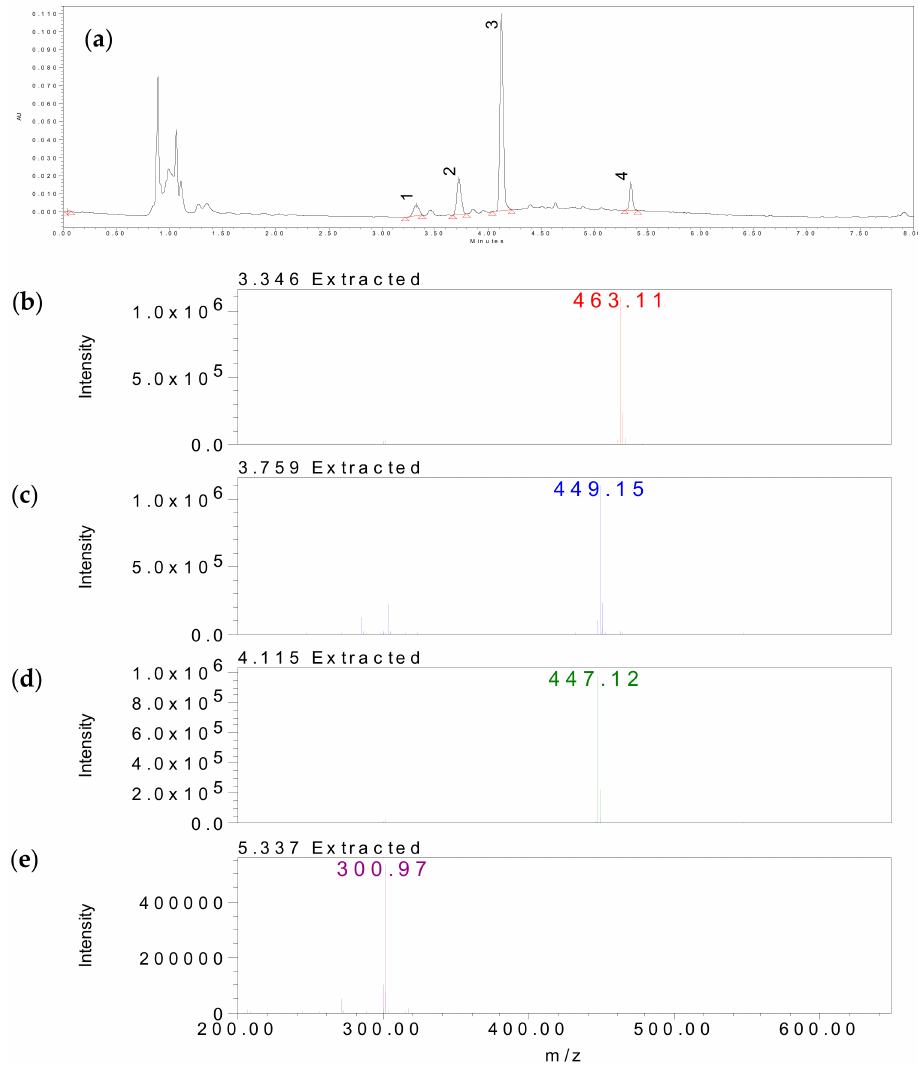
Figure 3. UPLC-DAD chromatograms obtained at 270 nm from Hypericum formosanum extract (HFE); ( a ) 1 = Hyperoside, 2 = Astilbin, 3 = Quercitrin, 4 = Quercetin; ( b ) MS of Hyperoside; ( c ) MS of Astilbin; ( d ) MS of Quercitrin; ( e ) MS of